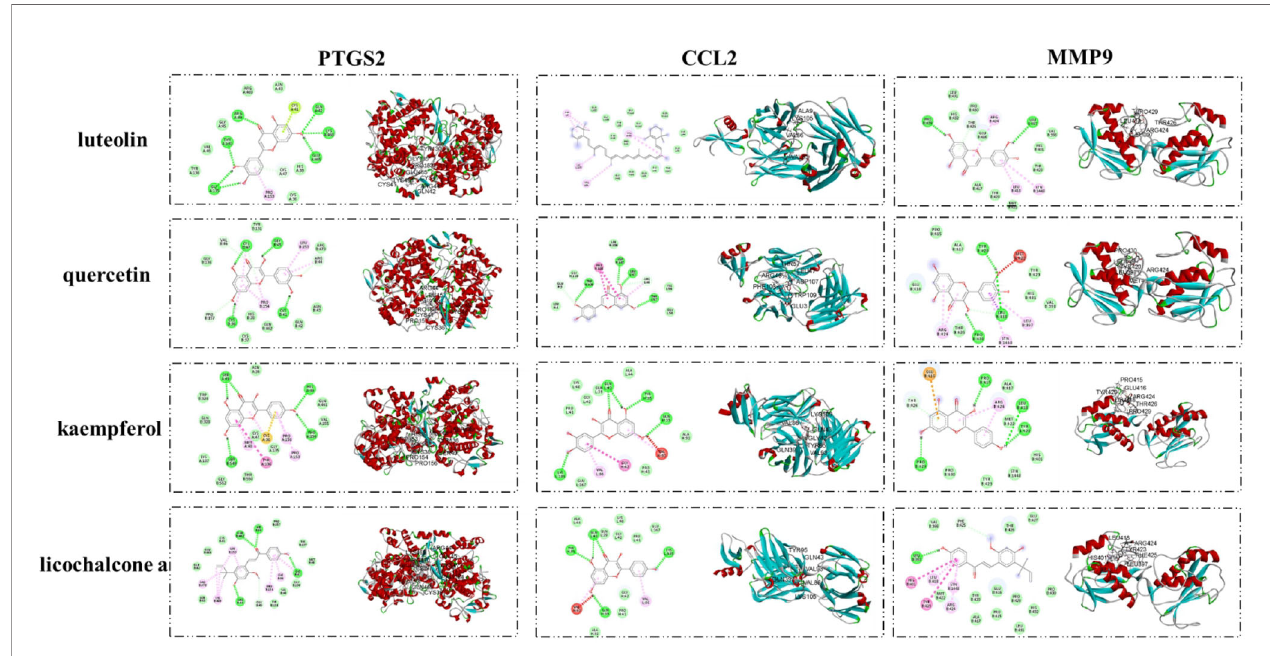
FIGURE 8 | Validation of interactions between QYSLS compounds and targets.